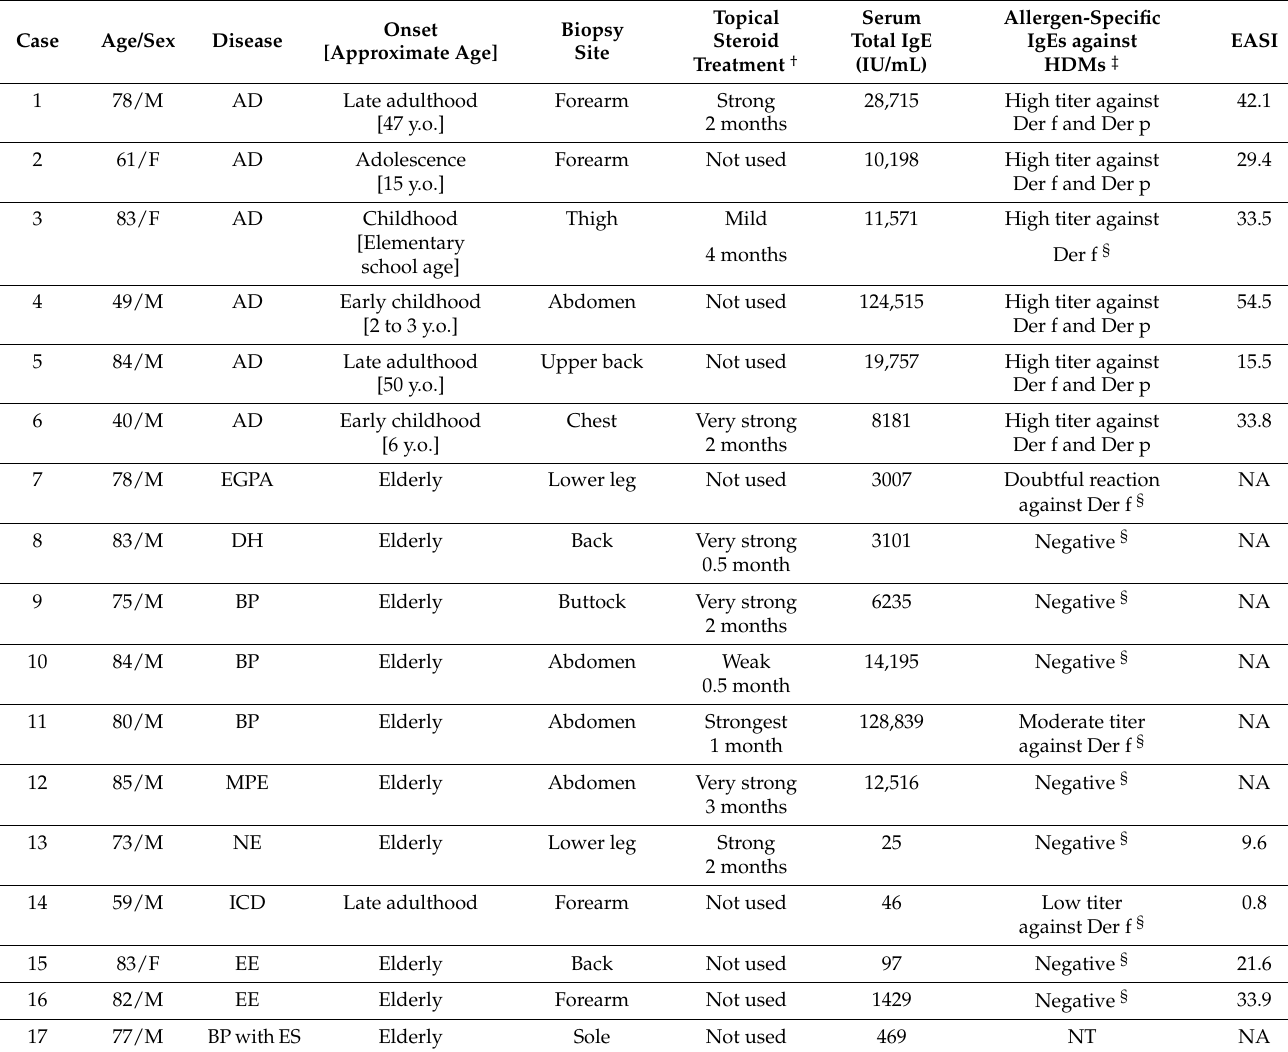
Table 1. Clinical and laboratory data of patients with atopic dermatitis and the control